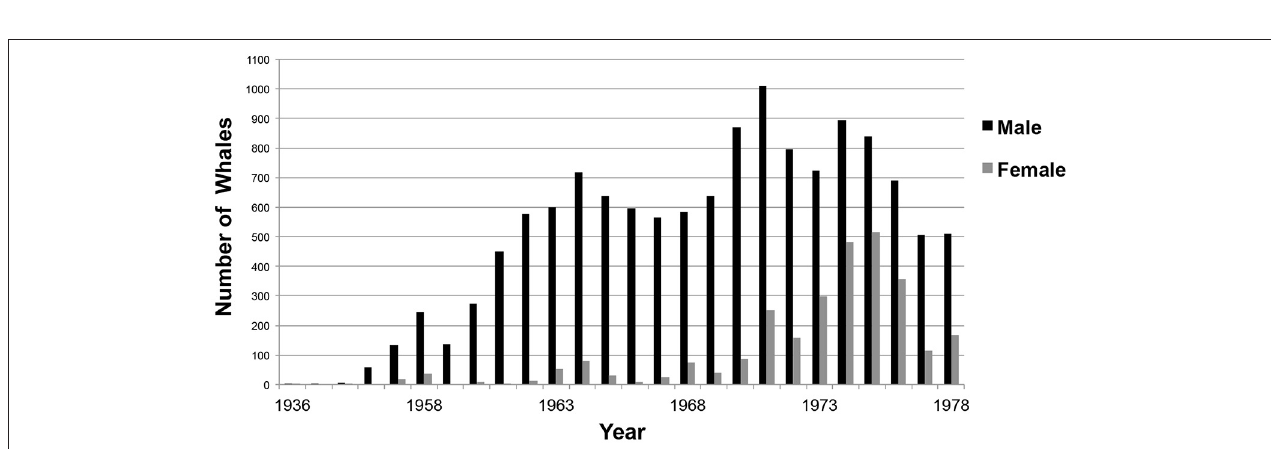
FIGURE 7 | Number of male and female sperm whales taken during commercial whaling operations off Western Australia by season between 1936 and 1978. ( n = 16,080; Source: IWC).